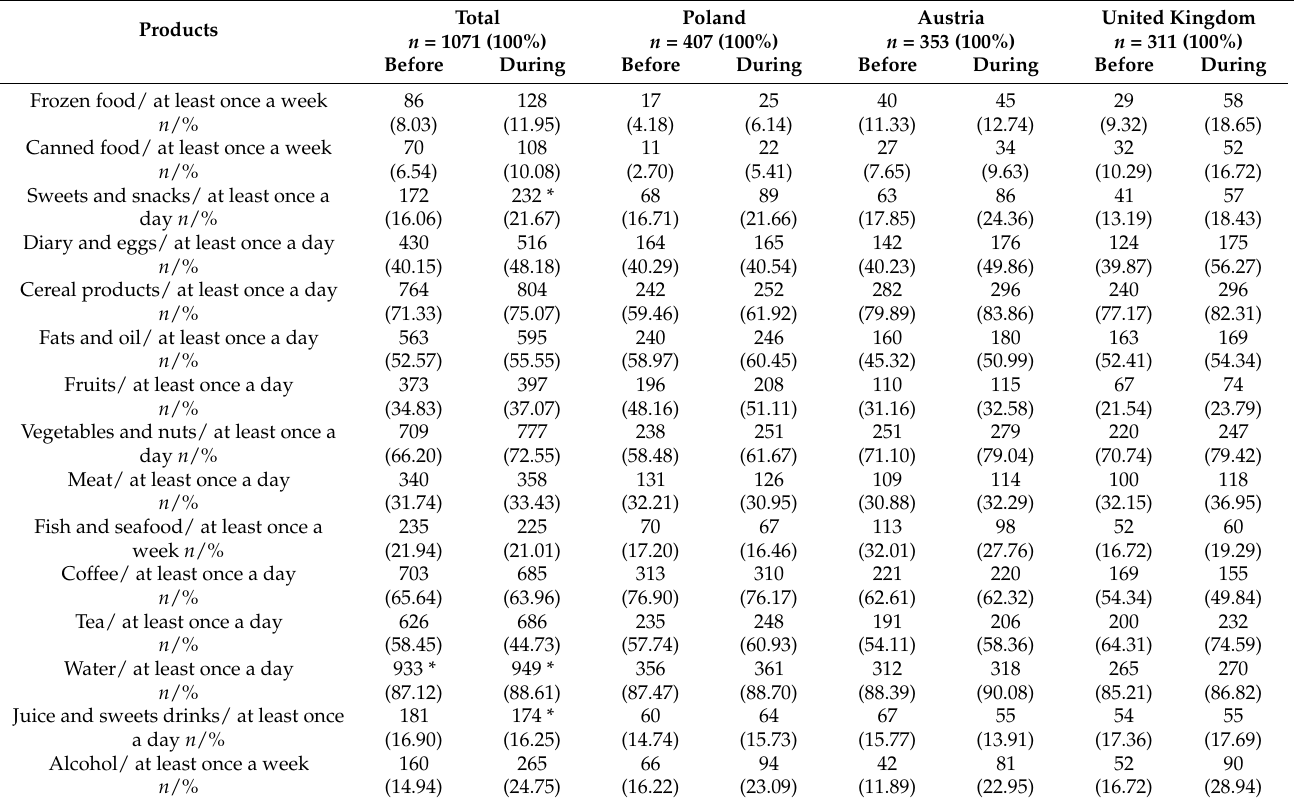
Table 3. The frequency of the consumption of selected products before and during